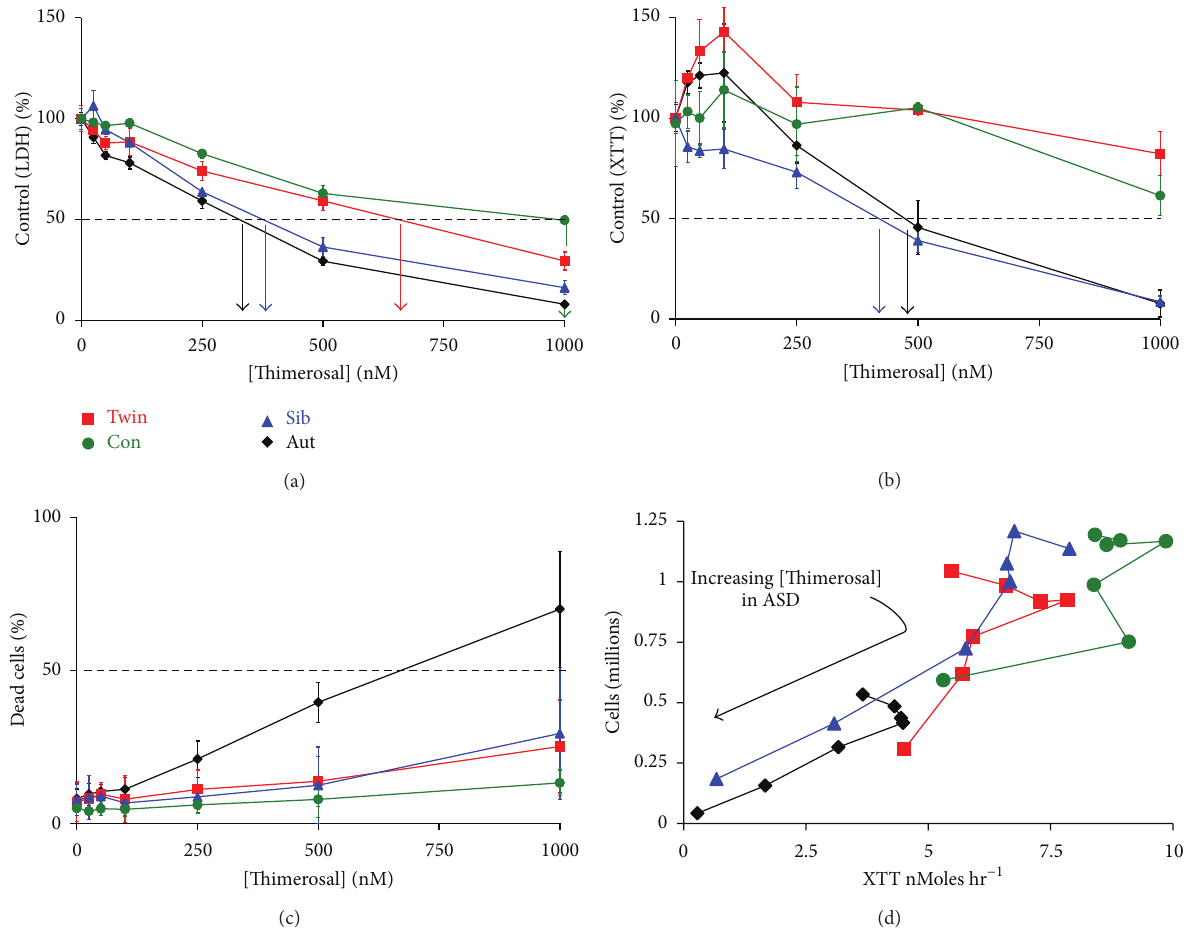
Figure 1: This figure shows the typical responses of a family of cells to thimerosal, measured on day 5 postinoculation. ASD = black, Twin = red, Sibling = blue, Control = green. (a) The percent control LDH values are plotted against increasing thimerosal concentrations for the 4 cell types. Arrows indicate LDH-G 50 values with ASD = 314nM, Twin = 648nM, Sib = 373 nM, and Cont = 1000nM. (b) The percent control XTT values are plotted against increasing thimerosal concentrations. XTT-G 50 values are obtained using the mitochondrial XTT assay. (c) The percentage of cellular LDH that is accessible to lactate (i.e., percentage of dead and dying cells) is plotted against thimerosal. (d) Cell number and XTT reduction rates as a function of increasing thimerosal concentrations are shown. The plots obtained are “hockey stick” in